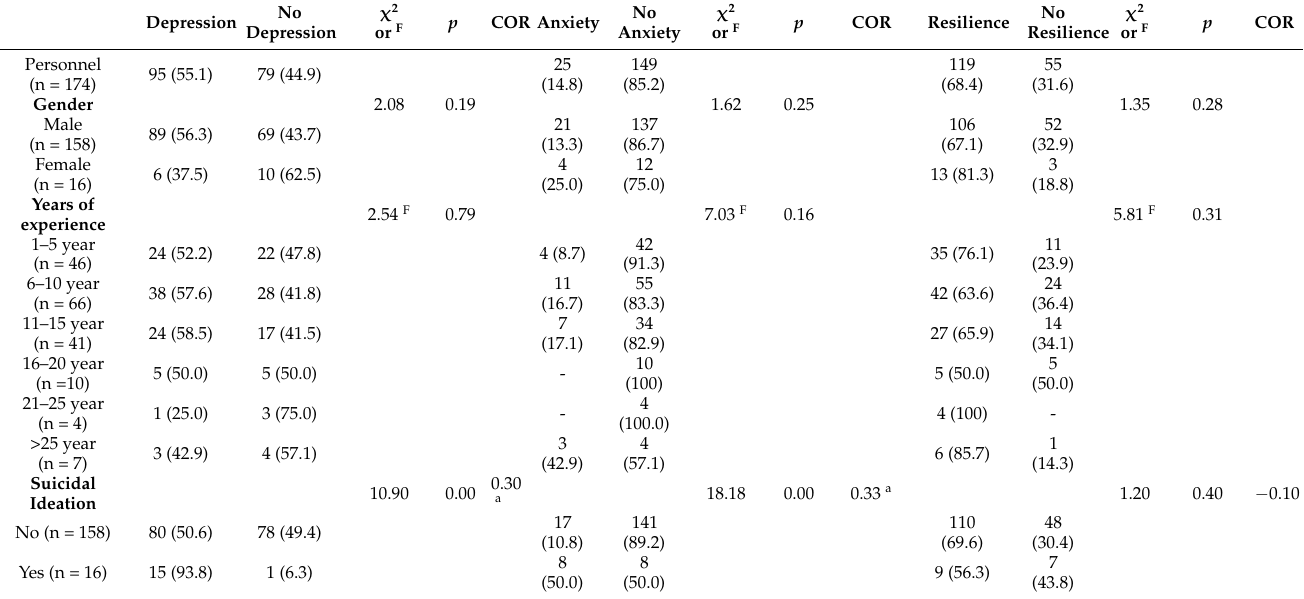
Table 2. Exploring the association between demographic variables, resilience, mental-ill health symptoms, and suicidal ideation.